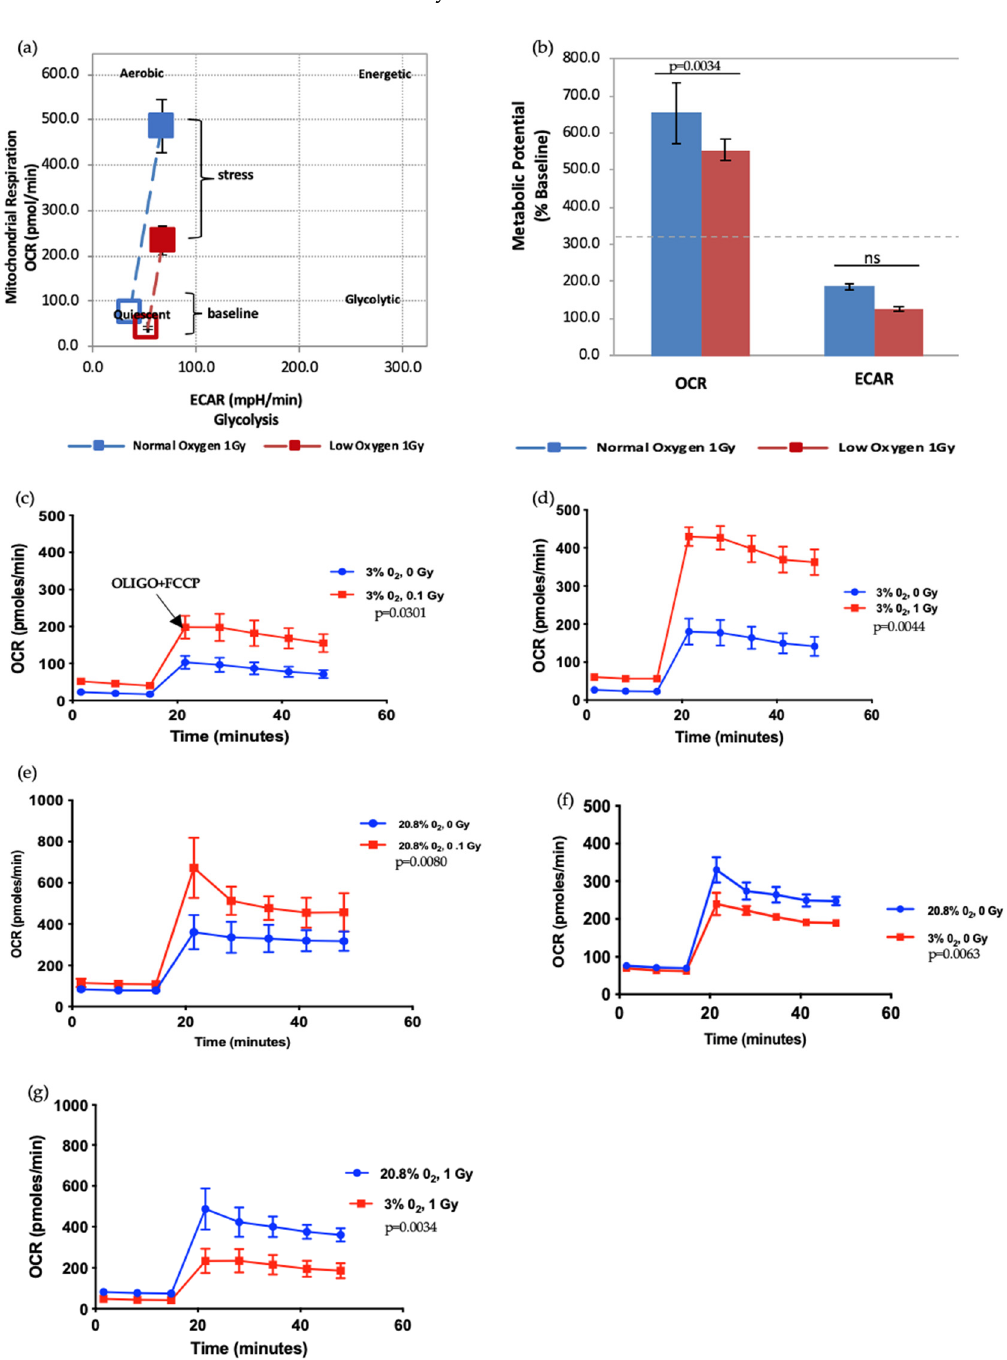
Figure 5. Seahorse XF Cell Energy Phenotype Test. ( a , b ) The phenotype map of 1 Gy exposed-HSPCs under normoxic and low O 2 environments. HSPCs were harvested from day 7 expansion cultures ( N = 3; error bars represent ± SEM). ( c – g ) Effect of different oxygen levels and radiation exposure on the metabolic potential of HSPCs. Student t -test applied for statistical analysis, p values are indicated separately for each figure.